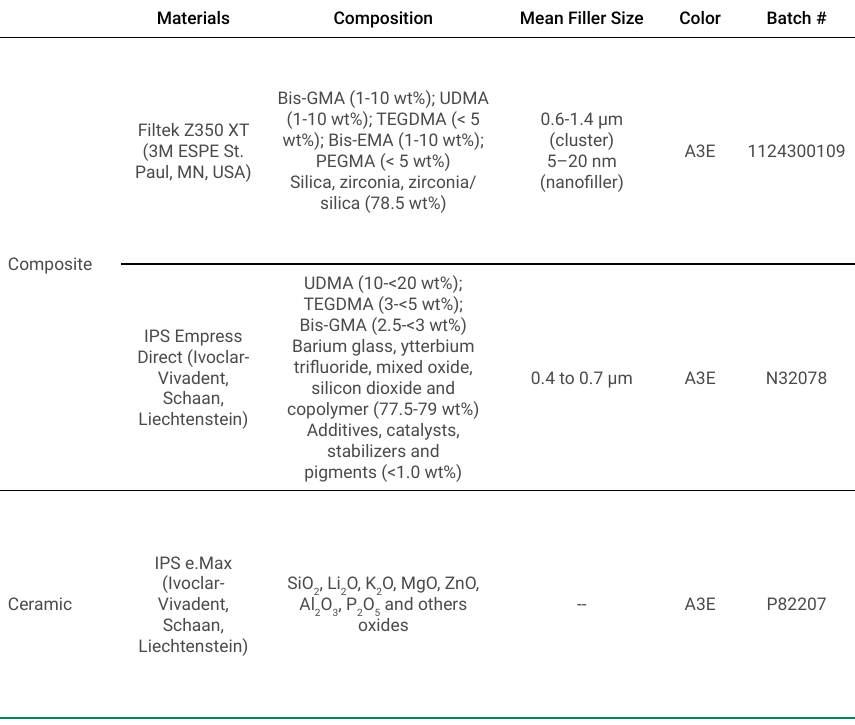
Table 1. Material, composition, color and batch of the tested materials. Materials Composition Mean Filler Size Color Batch